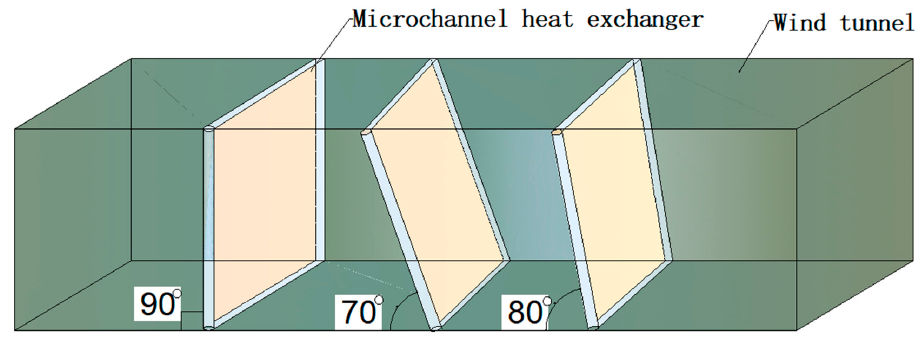
Figure 9. A schematic drawing of the MHE installation in the wind tunnel.